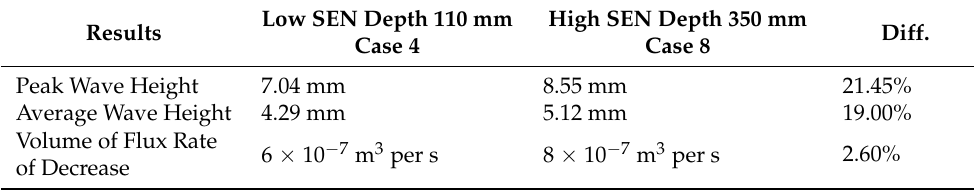
Figure 16. Low SEN depth (Case 4) vs. high SEN depth (Case 4) flux volume comparison. Table 4. Comparison of cases with a high and low SEN depth, namely cases 4 and 8.